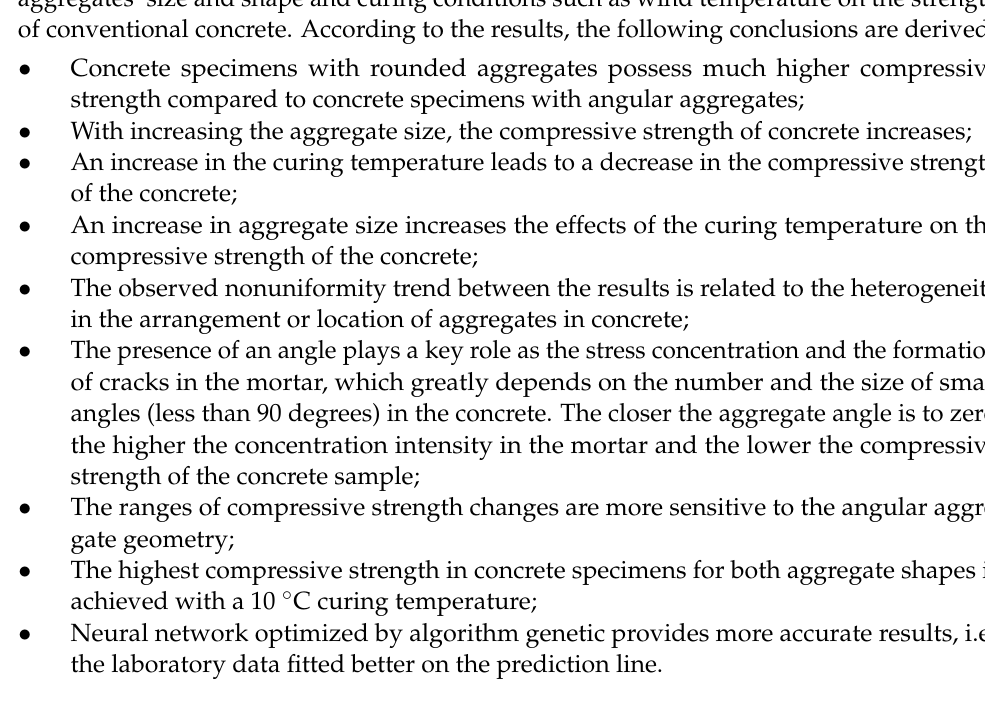
Figure 10. Comparison of experimental data and predicted data for BPNN-GA.